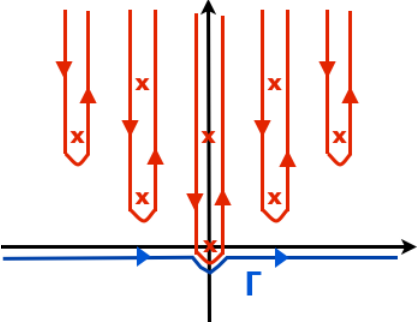
Figure 7. Picard-Lefschetz decomposition of the original contour of integration (cid:0). Each thimble identi(cid:12)es a di(cid:11)erent topological